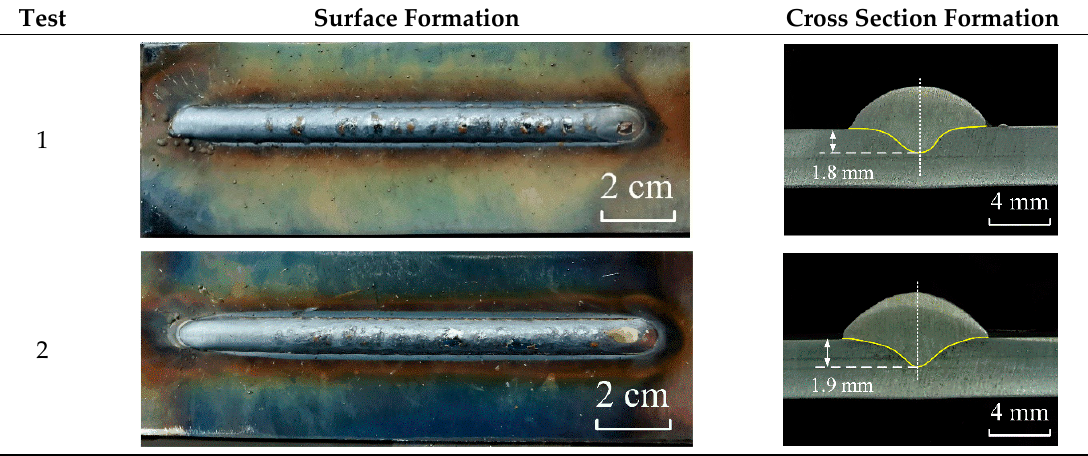
Figure 4. The formation of the weld bead in the partial projected transfer zone.